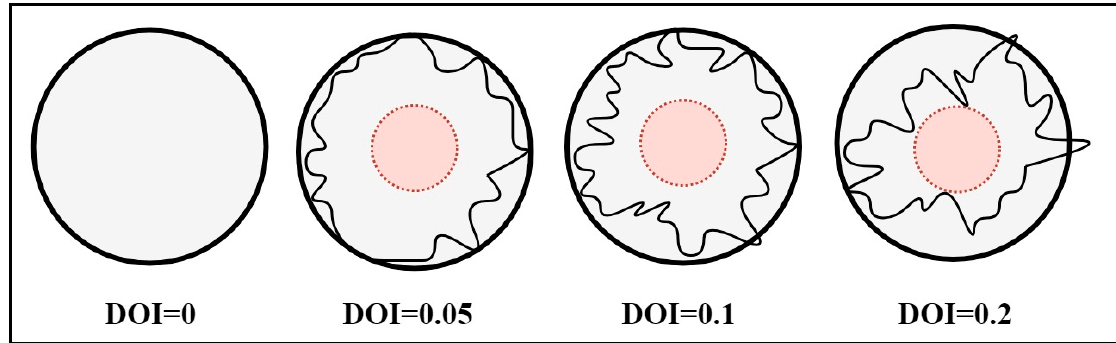
Figure 1. Radio pattern with degree of irregularity (DOI).